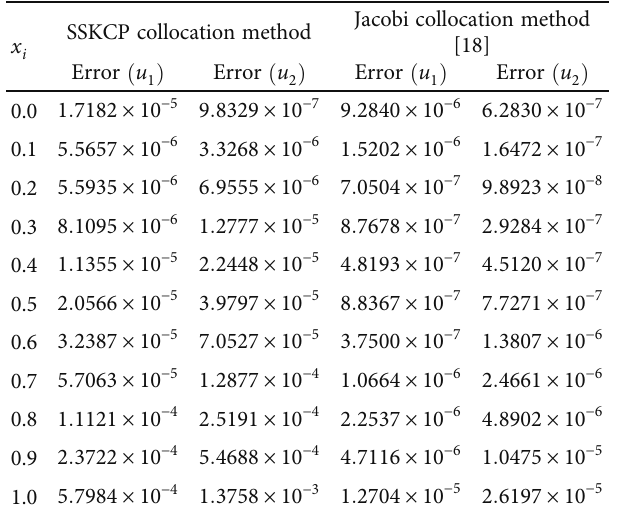
Figure 7: Some illustrations for the exact and approximate solutions using di ff erent values of ν Example 2. Table 4: Comparison between absolute errors of SSKCP collocation and Jacobi collocation methods at equally spaced points for N = 12 in Example 3.